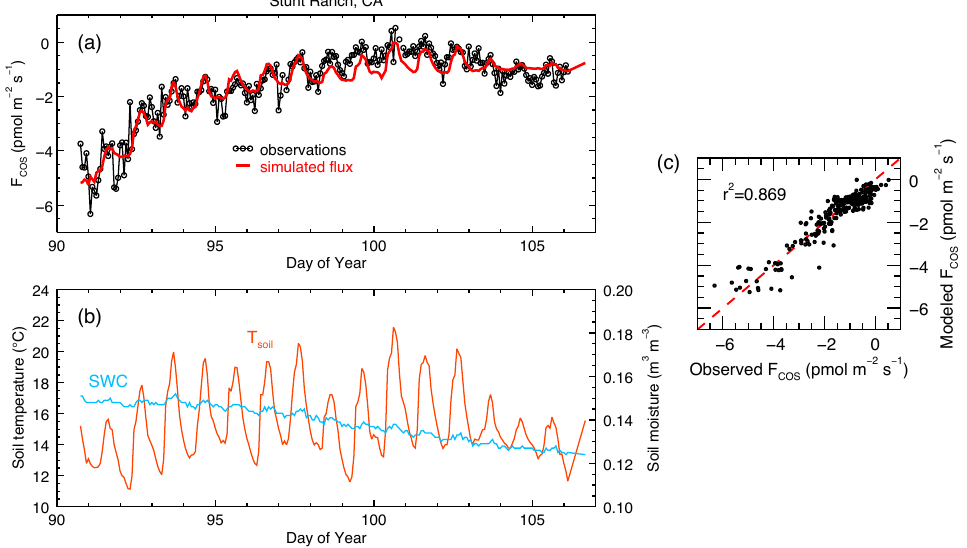
Figure 6. (a) Observed COS fluxes (black) and modeled COS fluxes (red) at the Stunt Ranch site. (b) Surface soil temperature and moisture at the site during the same period. (c) Model vs. data for COS fluxes.